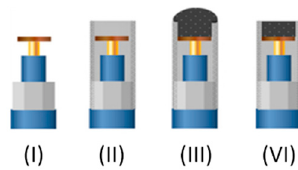
Figure 3. Scheme of the step-by-step construction of graphite-epoxy composite electrodes. ( I ) Copper disk soldered to the connector. ( II ) Assembly into the PVC tube. ( III ) Incorporation of graphite-epoxy mixture. ( VI ) Polishing of the hardened surface.